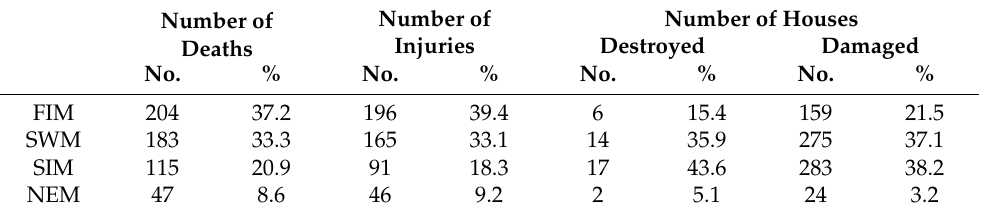
Table 7. Seasonal variations of lightning accidents in Sri Lanka, from 1974 to